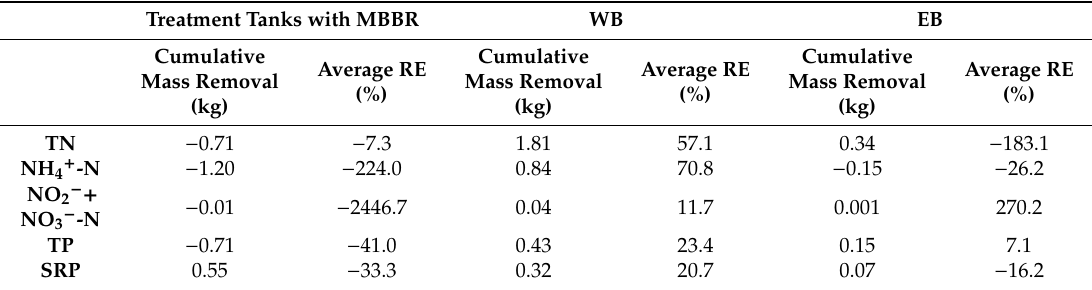
Table 3. Cumulative nutrient mass load removal and mean removal efficiency for each part of the system (i.e., treatment tanks with MBBR, West Bioreactor (WB), and East Bioreactor (EB)) for five storm events where no bypass of treatment tanks occurred.